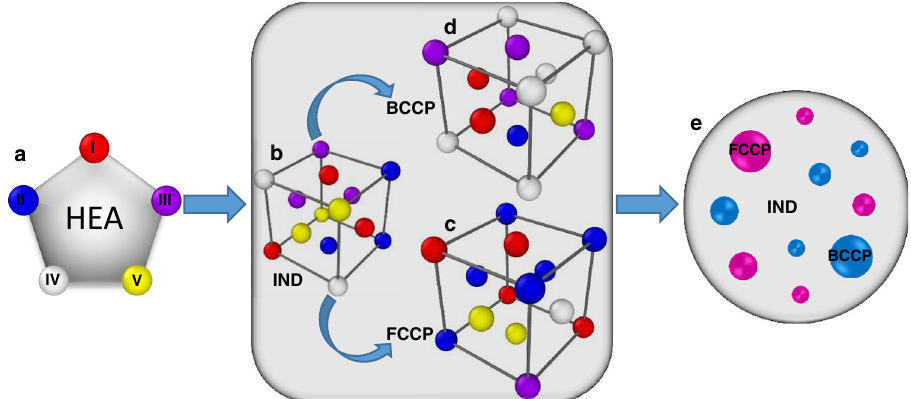
Fig. 6 Schematic diagram illustrating the strategy to design HEAs with simultaneously enhanced strength and ductility via short-range ordering. a Design a HEA with fi ve elements (I, II, III, IV, and V). Formations of ( b ) IND, ( c ) FCCP, and ( d ) BCCP clusters via short-range ordering. e The IND clusters serve as a matrix with the FCCP clusters serve as hard fi llers to enhance the strength and BCCP clusters act as (plastically) soft fi llers to increase the